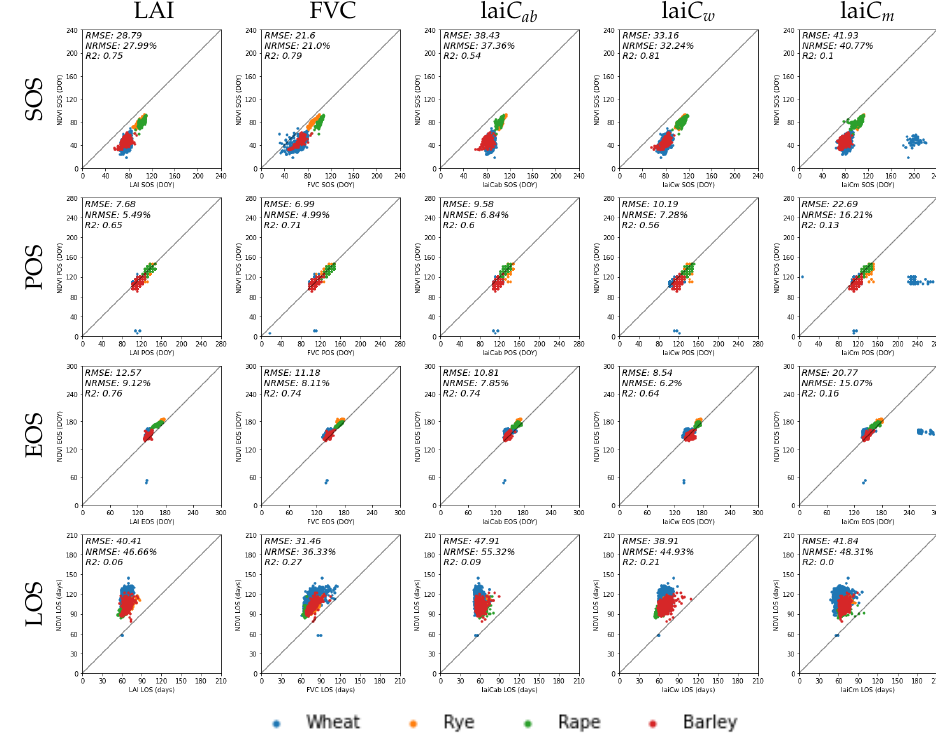
Figure 9. Comparison of Start of Season (SOS), Peak of Season (POS), End of Season (EOS) in day of the year (doy) as well as Length of Season (LOS), derived from NDVI and multiple crop traits. Case study site in the region of Castile and Leon, Spain in 2019. See Figure 2 for the